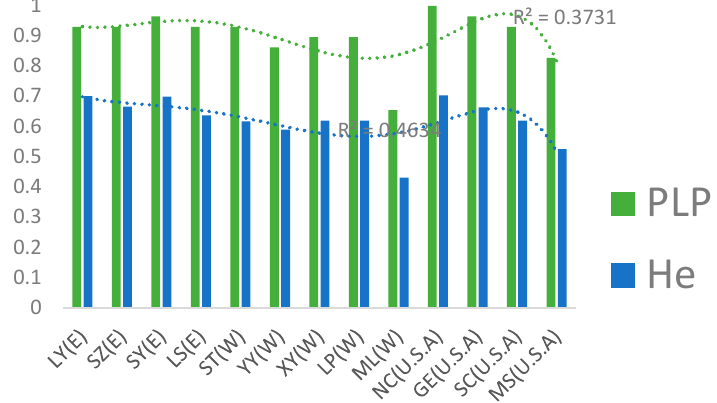
Figure 4. Genetic diversity and trendline of nine L. chinense provenances and four L. tulipifera provenances. The genetic diversity of the western China provenances was lowest compared to the others. E in the bracket represents the eastern China population and W indicates the Western China population. The conjunction curve is a sextuple polynomial. He: expected heterozygosity; PLP: the proportion of polymorphic loci at the 5% level.